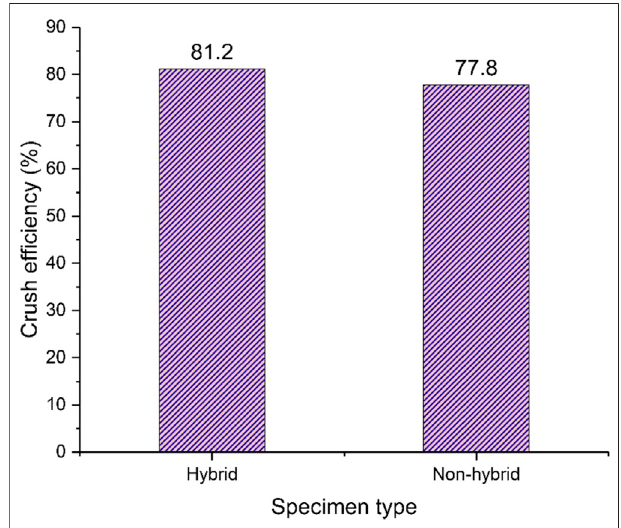
FIGURE 7 | A comparison of ɳ c between hybrid and nonhybrid composite specimen.